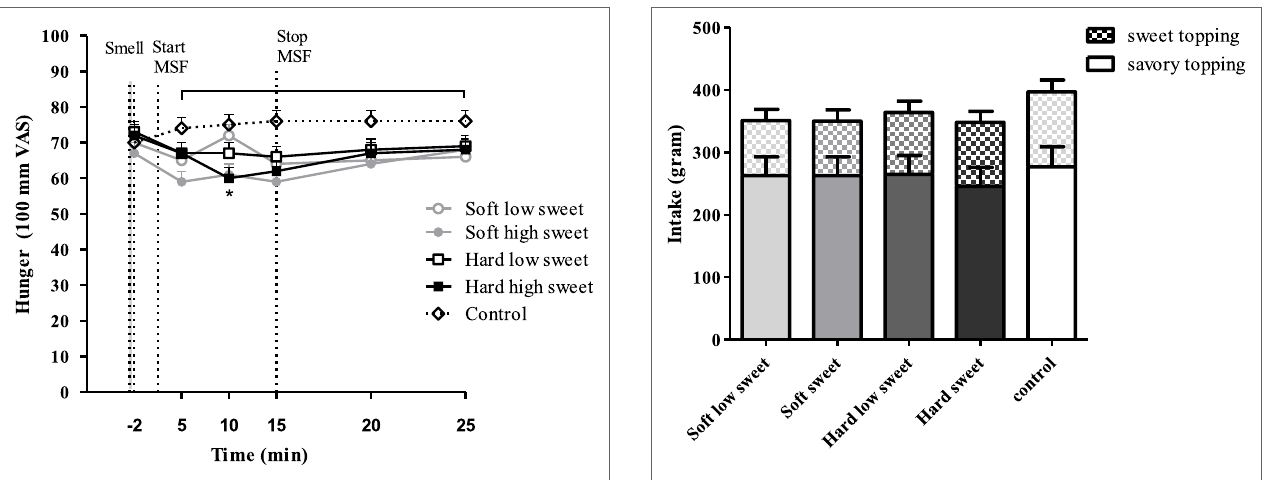
FigUre 10 | Estimated mean ± SEM hunger changes over time per treatment and control condition. Significant differences were found between treatments and control indicated by the bracket ( p < 0.05). *Significant taste effect ( p = 0.003).